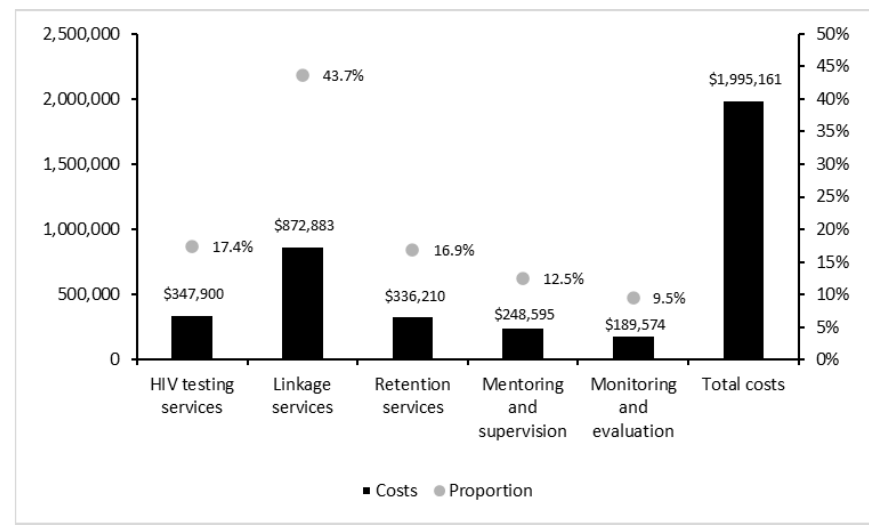
Figure 2. Total program costs by program activity (in 2018 USD).